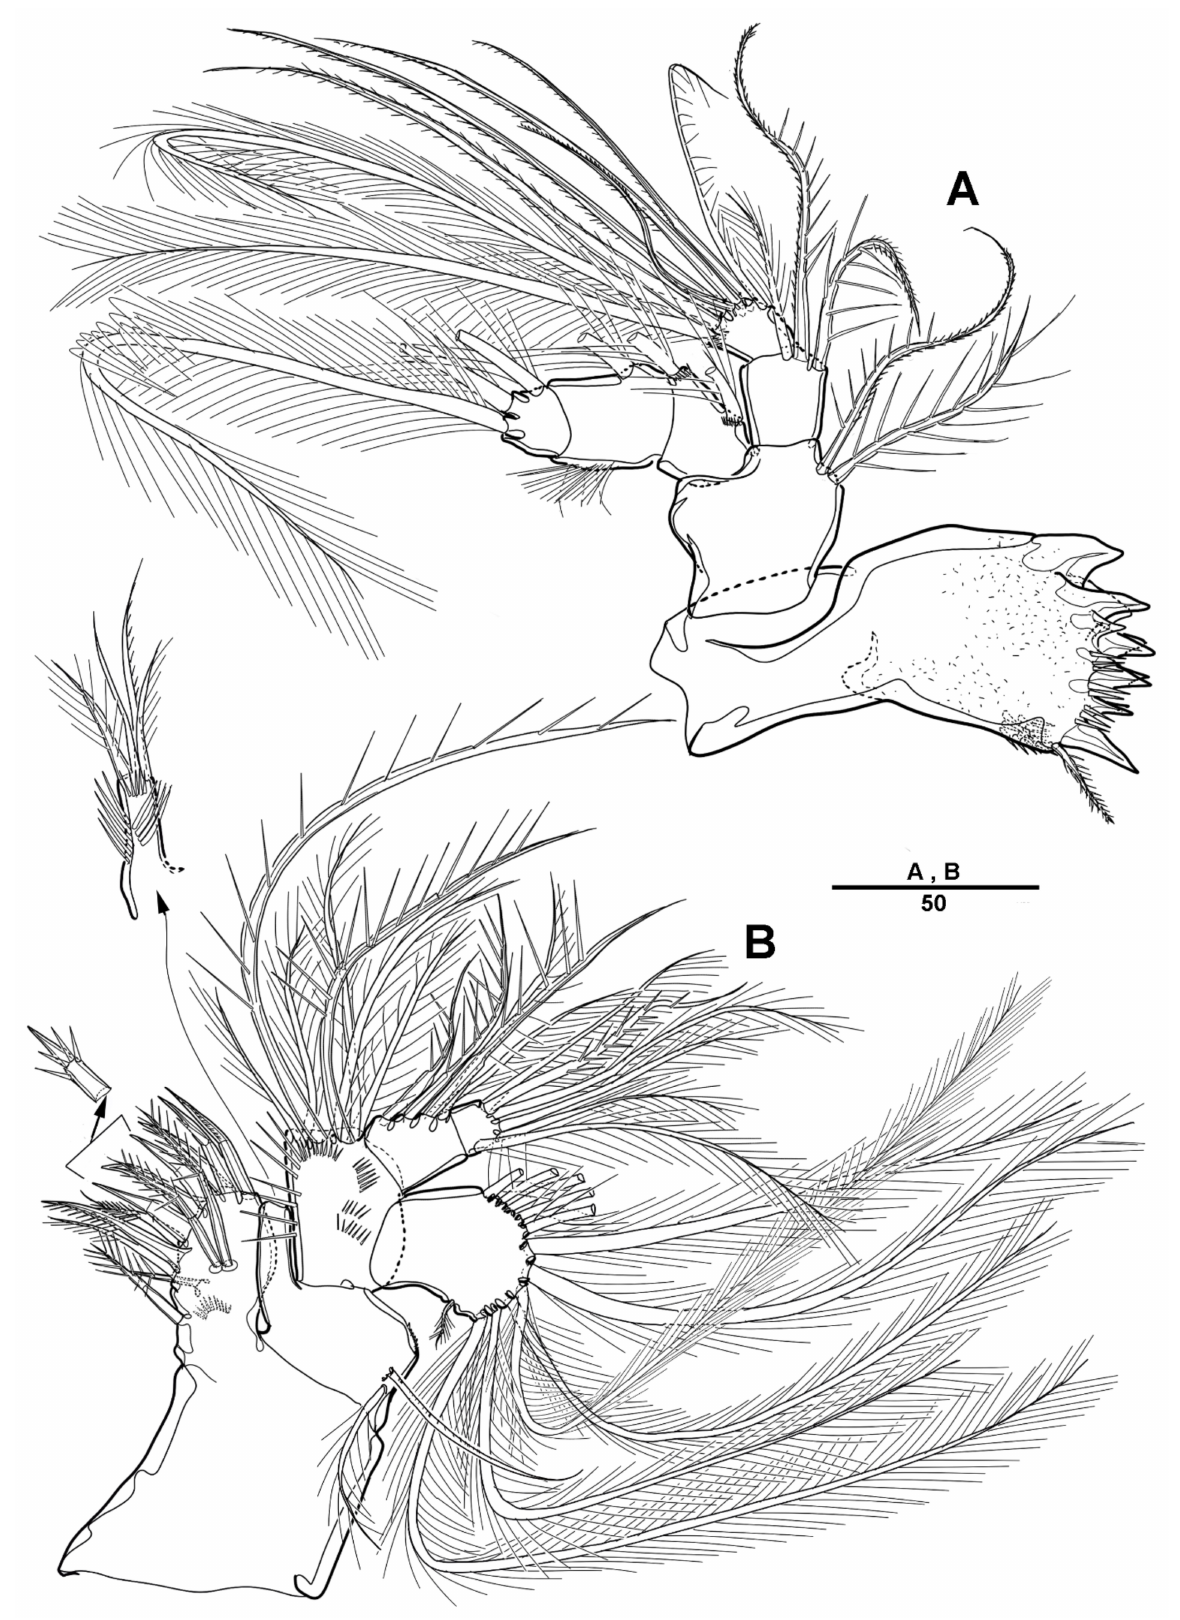
Figure 15. Scottolana wonchoeli sp. nov. holotype female: ( A ) mandible; ( B ) maxillule. Scale bars in µ